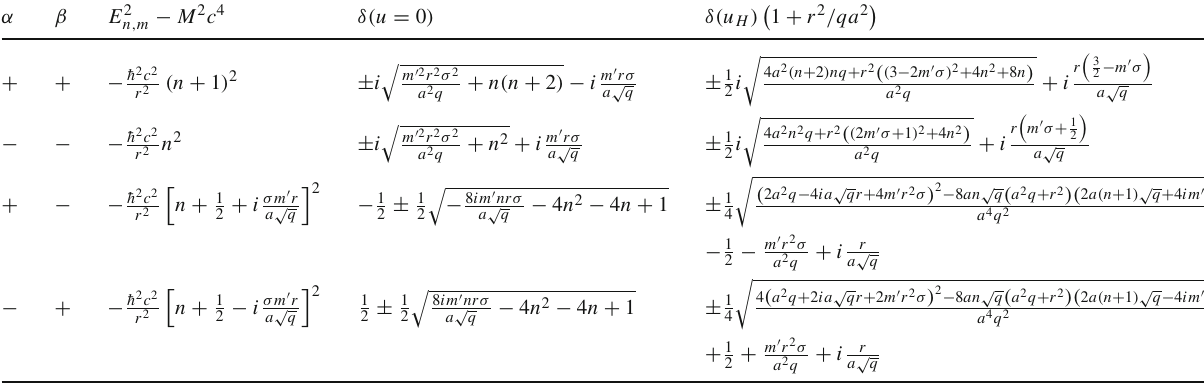
Table 1 Summary of the energy levels E n , m (cid:3) , and the asymptotic parameter δ of the solutions in ( 1 + 2 ) -dimensional wormhole with constant magnetic